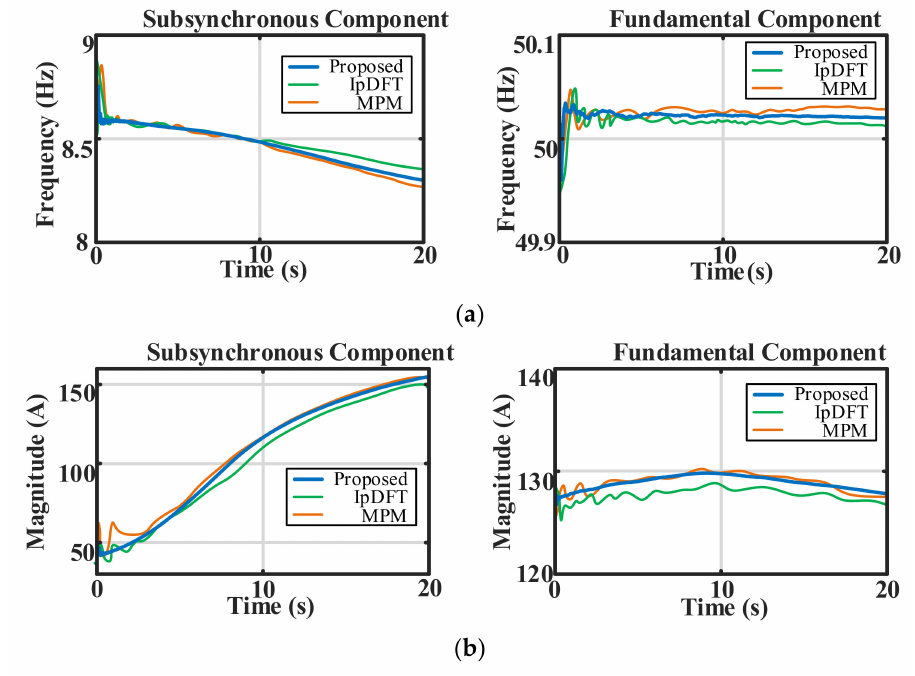
Figure 14. Results of parameter identification. ( a ) Frequency identification results, ( b ) Amplitude identification results.